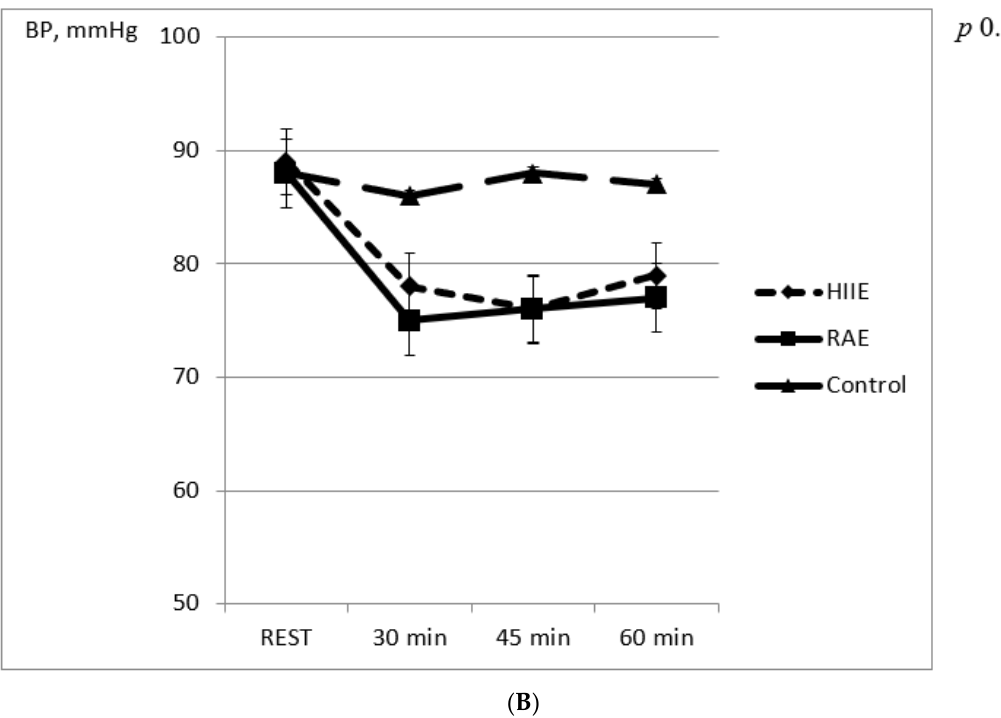
Figure 1. ( A ) Changes in systolic blood pressure in the first hour after experimental sessions. ( B ) Changes in diastolic blood pressure in the first hour after experimental sessions.